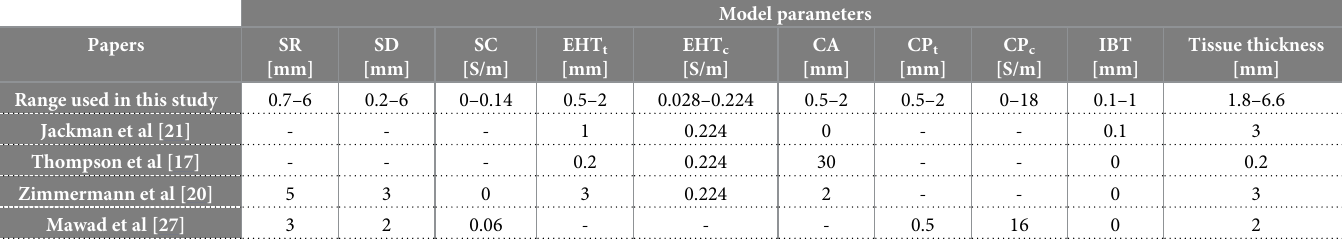
Table 3. Modifications to model parameters to match the experimental studies setups. The first row reports the ranges used in our simulation study, while the rows below display the parameters values used to replicate each of the 3 experiments.